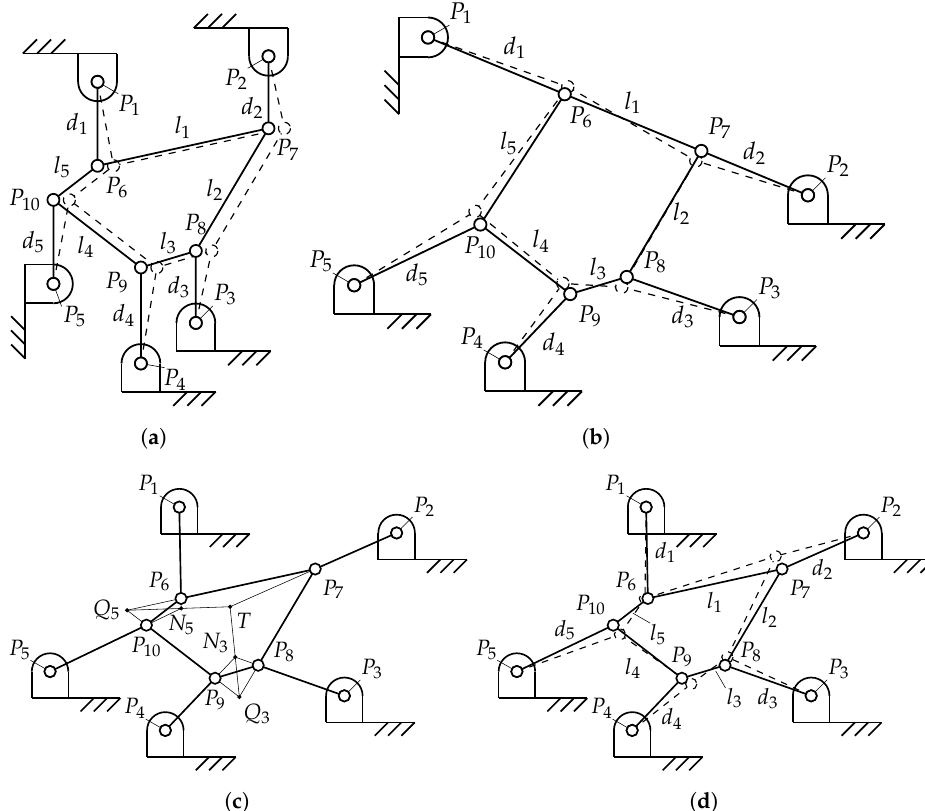
Figure 5. Some examples of type-2 kinematic singularities of a 5-RR structure (derived from a 5-RRR mechanism): ( a ) a singularity occurring when all links P i P n + i are parallel; ( b ) a singularity occurring when three consecutive links are aligned; ( c ) a singularity configuration derived from [45]; ( d ) the auxiliary figure of Figure 5c. For each structure, we also show (in dashed lines) a configuration which is close to the singular one; this approximates the infinitesimal motion that the structure can have around its singularity (for Figure 5c, we added the auxiliary Figure